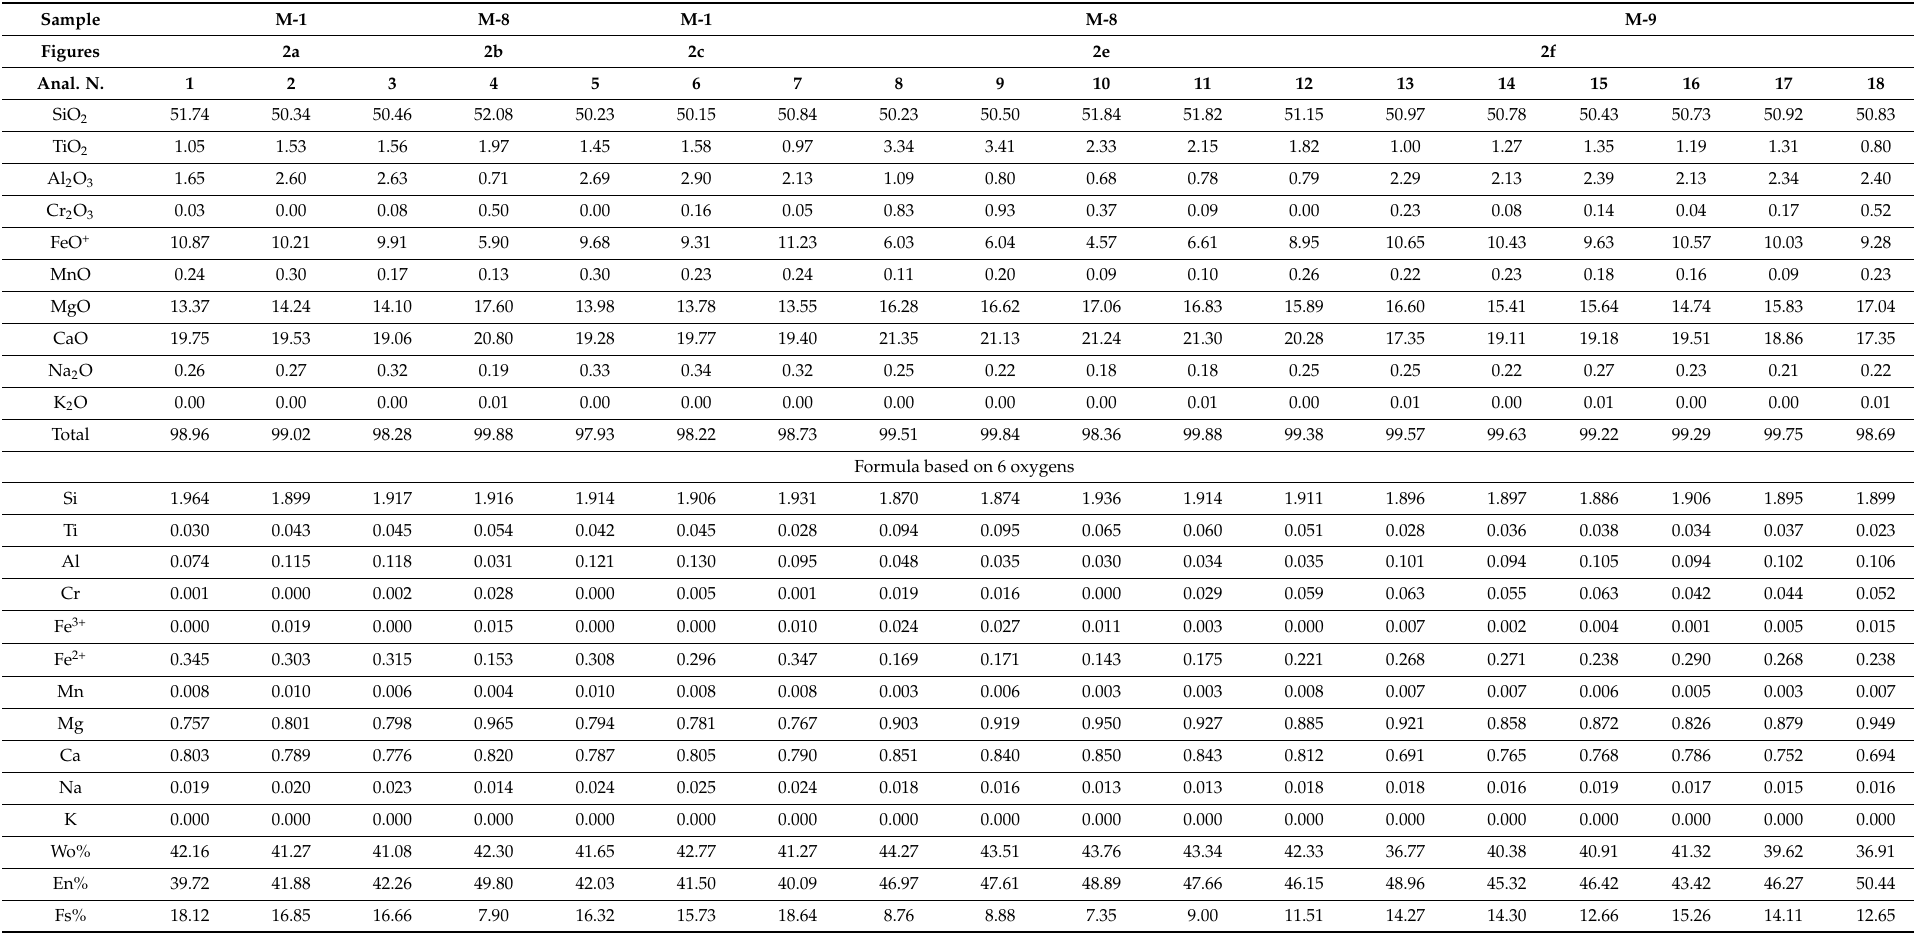
Table 2. Selected analyses of